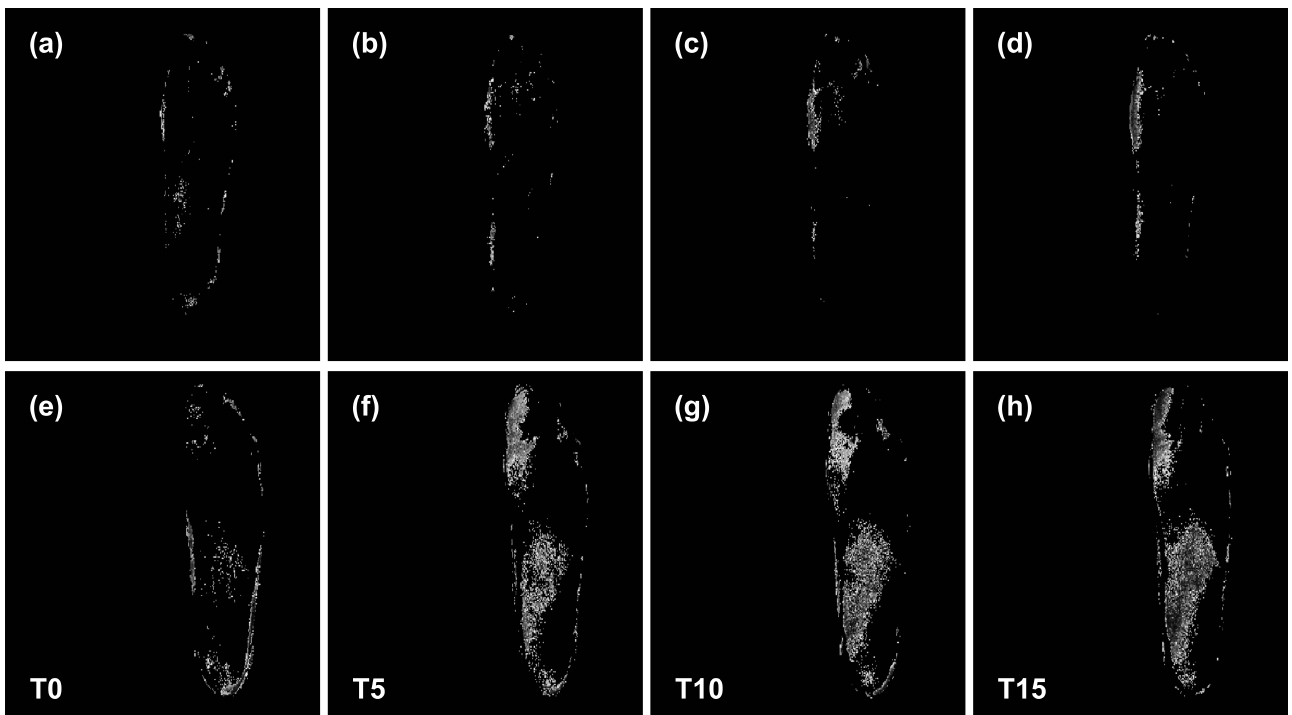
Figure 7. Statistically significant p values map, for each gender, at each time point, T0, T5, T10 and T15. The upper row corresponds to the female subjects ( a – d ), whereas the lower to the male subjects, ( e – h ), respectively.